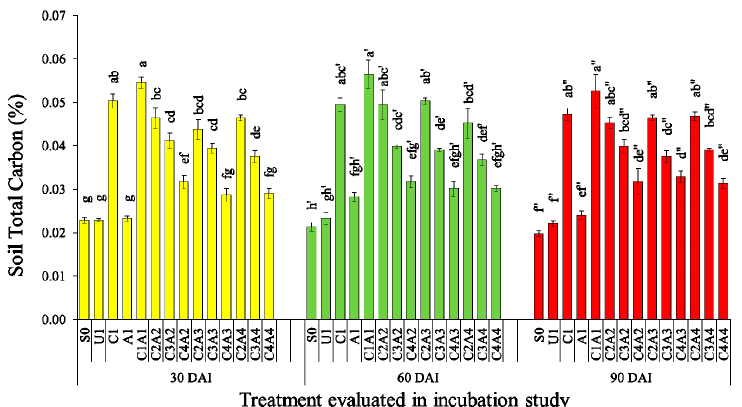
Figure 8. Treatments on soil total carbon after thirty, sixty, and ninety days of incubation. Means with different letter(s) within the same incubation period indicate significant difference between treatments by Tukey ’ s HSD test at p ≤ 0.05. Bars represent the mean values ± SE. Application of charcoal and sago bark ash increased soil exchangeable K + (Figure 9).